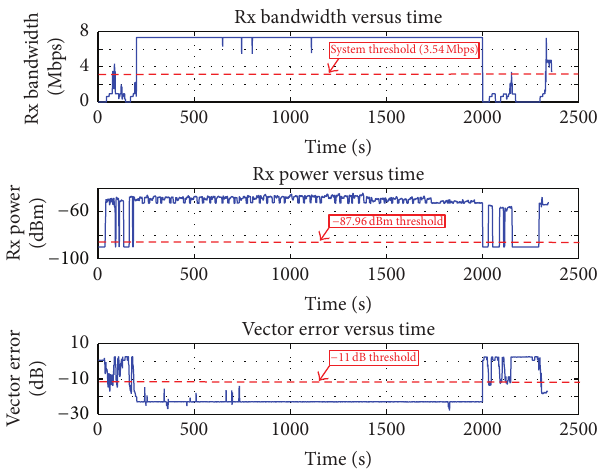
Figure 17: System bandwidth, Rx power, and vector error of MAB (predesigned fuzzy